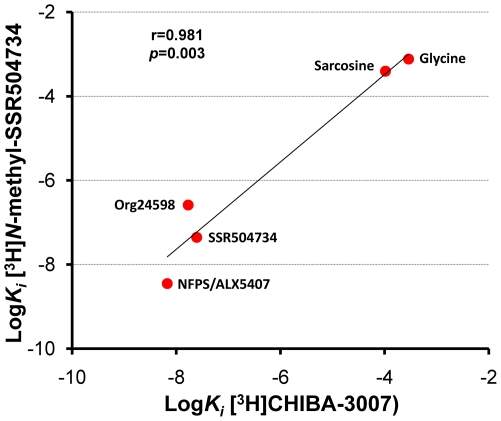
Comparison between Ki values of various drugs for inhibiting [3H]CHIBA-3007 binding and [3H]N-methyl-SSR504734 binding.Data of [3H]CHIBA-3007 are from Table 1. There was a significant (r = 0.981, p = 0.003) correlation between the potency for inhibiting of 5 compounds (NFPS/ALX5407, SSR504734, Org24598, sarcosine and glycine) for [3H]CHIBA-3007 binding and [3H]N-methyl-SSR504734 binding [31].